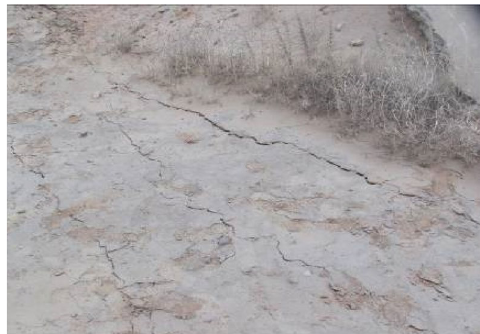
Figure 2. Cracks on the surface.